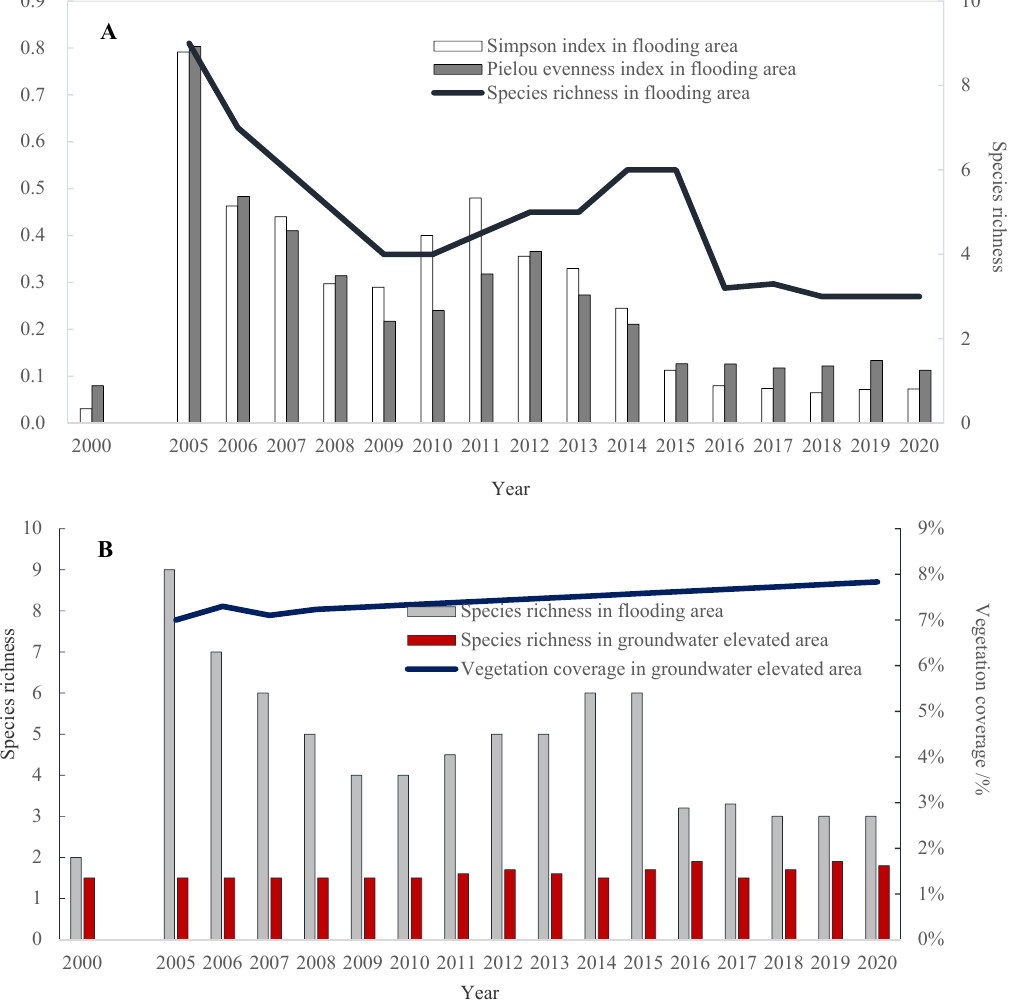
Figure 9. Plant diversity indices in flooding area ( A ) and species richness in flooding area and in groundwater elevated area ( B ).